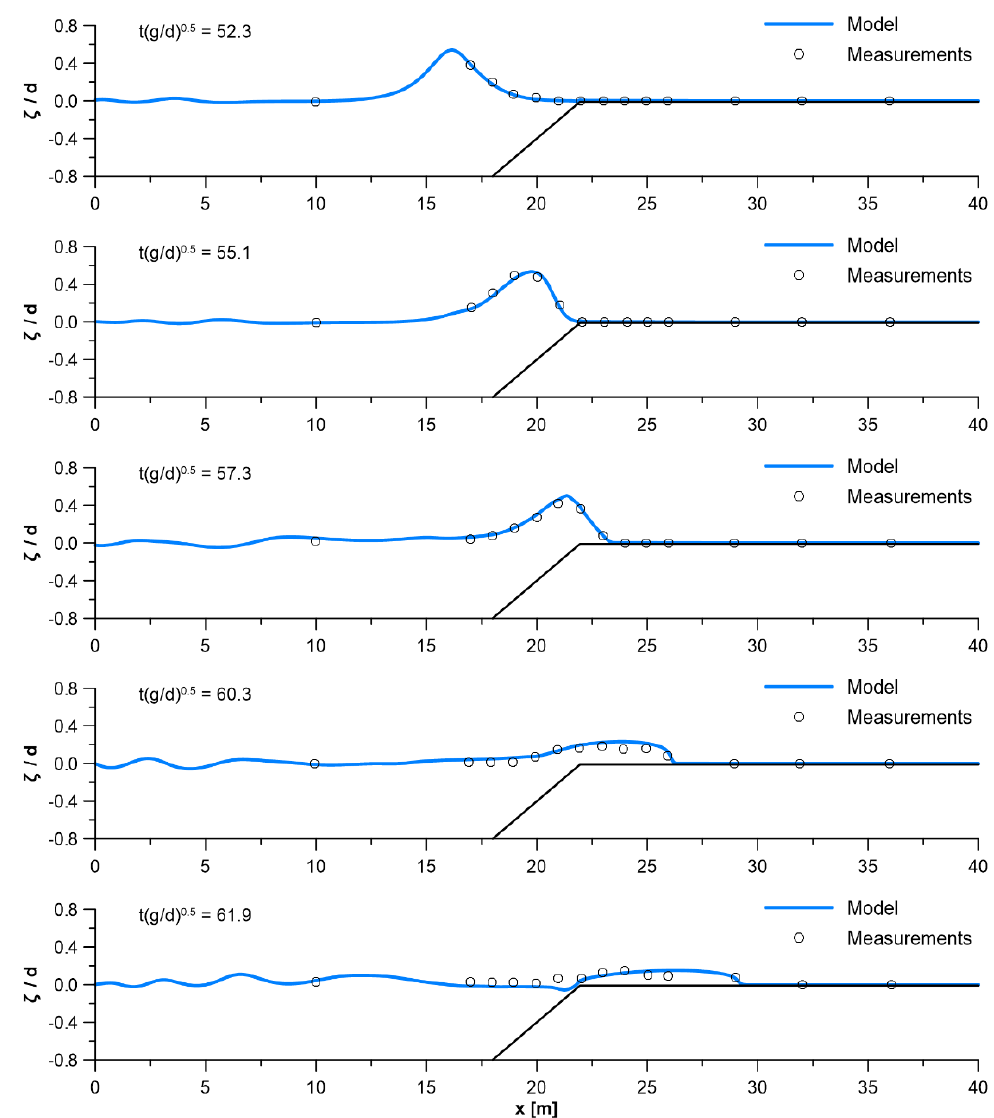
Figure 1. Surface profiles of solitary wave transformation over a dry reef flat with A/d = 0.5 and a 1:5 slope. Solid lines denote the results of the presented advanced nearshore wave propagation model (see Section 2.3) and circles denote the measurements of [38].